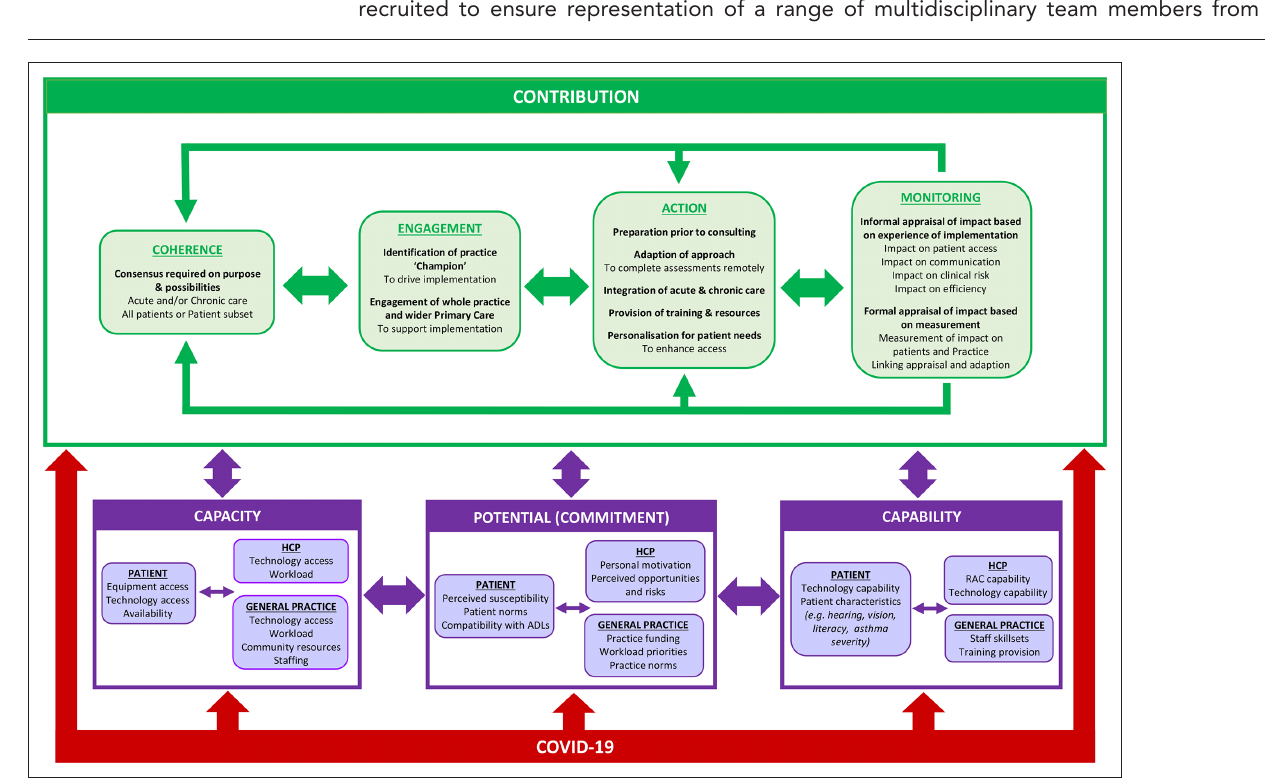
Figure 1 Summary of findings: work by members of the general practice team during implementation of remote asthma consulting in response to the COVID- 19 pandemic, and contextual factoring impacting implementation. ADLs = activities of daily living. HCP = healthcare professional. RAC = remote asthma